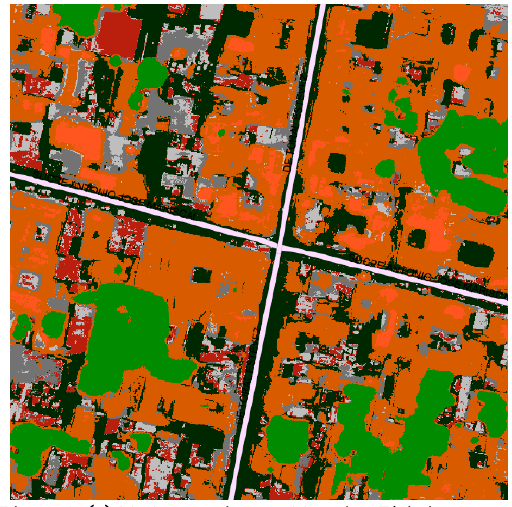
Figure 4. (a) 2013 raster image, 30cm/px, This image was classified and generalized with the SVM lineal